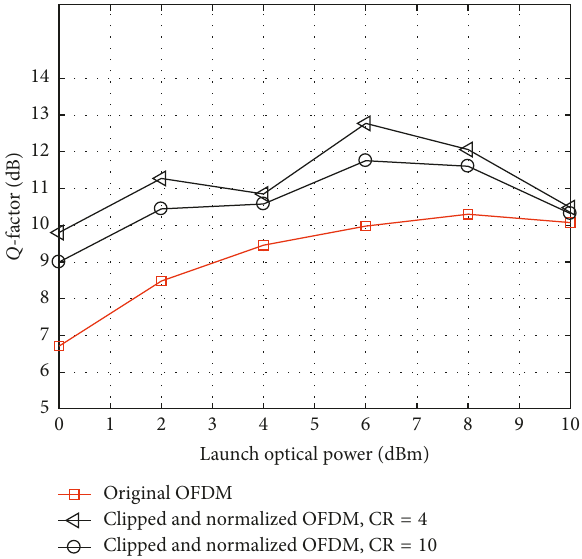
Figure 9: Q factor values as a function of the launch power in 4 Gs/s QPSK DCO-OFDM after 100km of